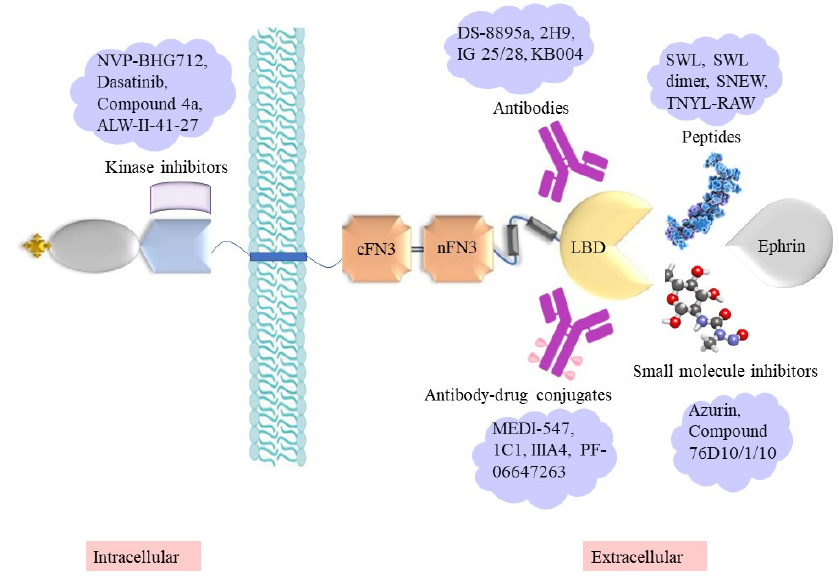
Figure 4. Illustration of potential therapeutic approaches targeting sites of Eph receptors.